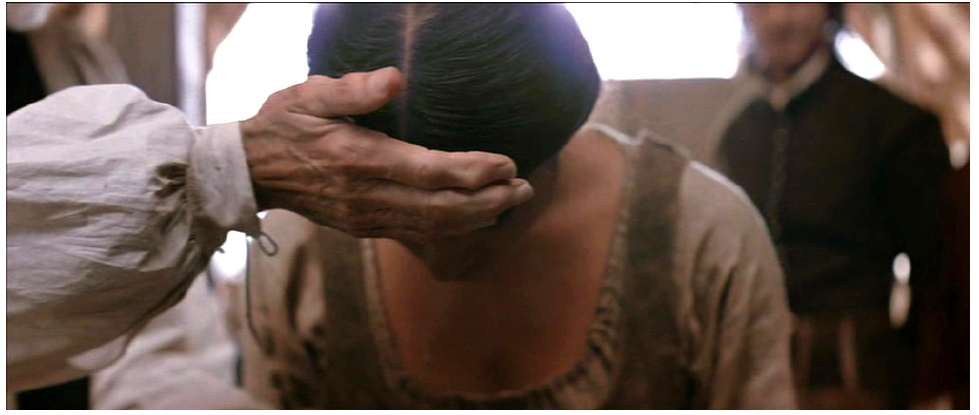
Figure 13: Pocahontas is baptised in